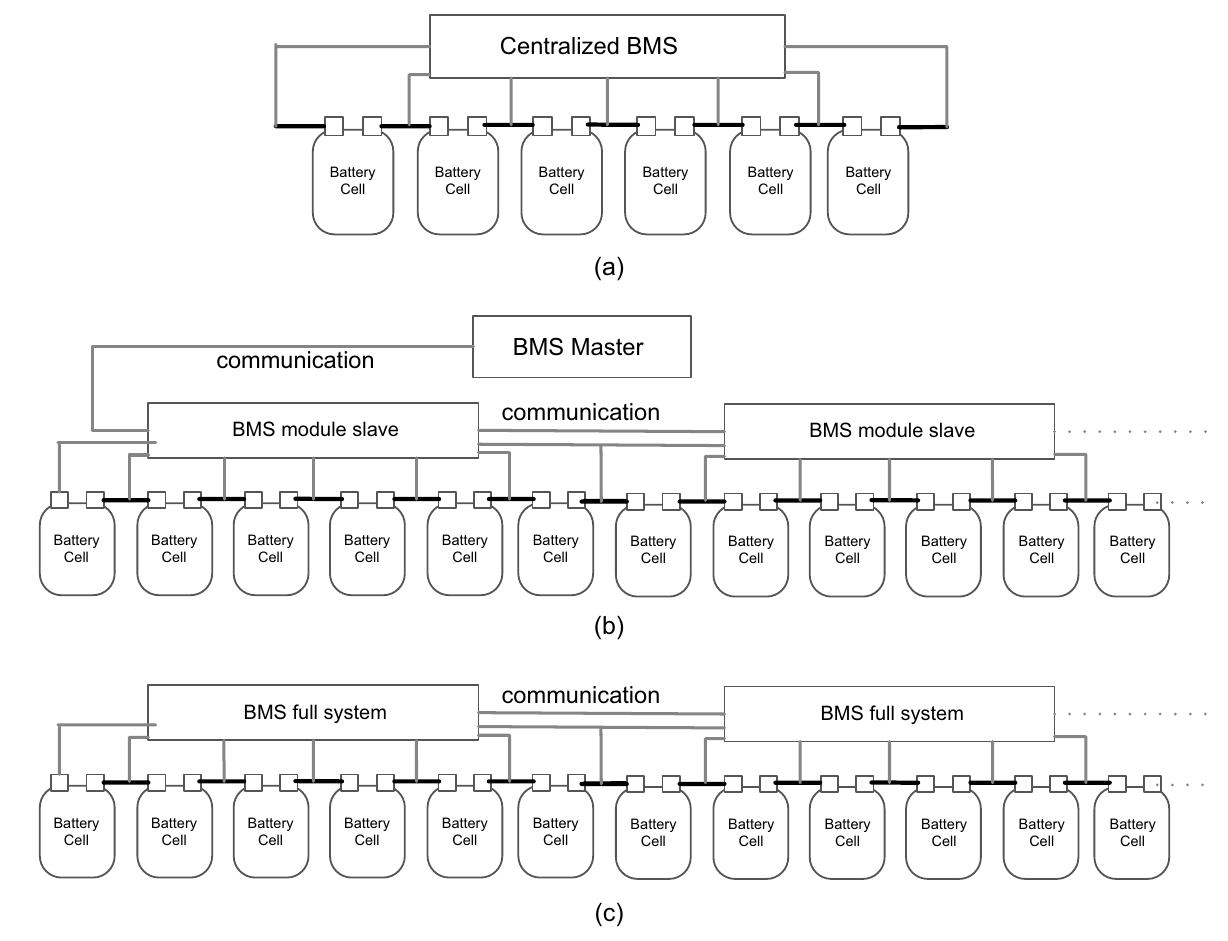
Fig. 2 Typical topology of large-scale battery pack BMS systems. a Centralized network; b Modularized/distributed network; c Decentralized